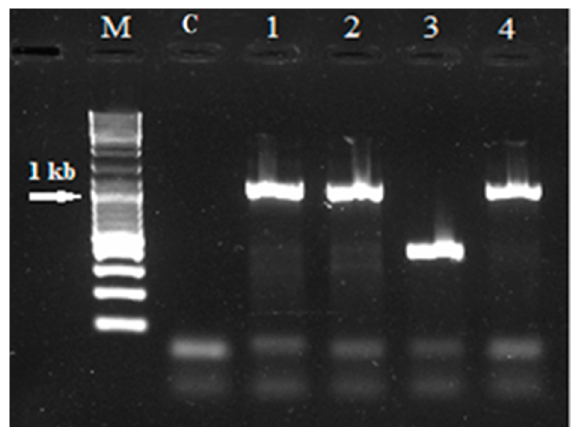
Figure 2. PCR products containing the rolB/C -like gene in cranberry samples. (M) Molecular Weight Marker (samples 1,2—full size, 3—the most common deletion); and (4) V. macrocarpon . Table 2. Studied genotypes of Vaccinium and their allelic